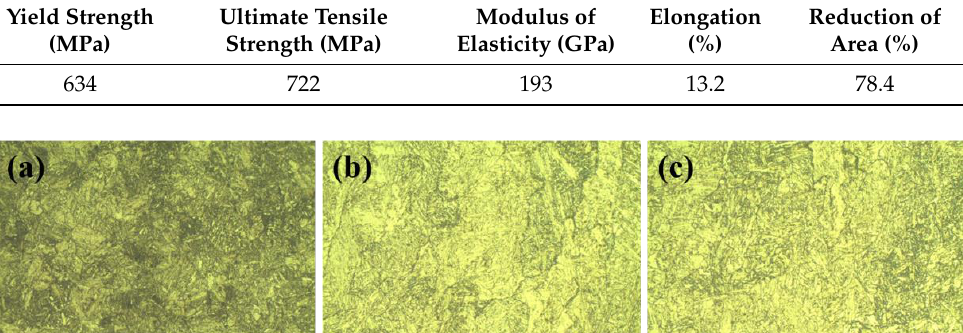
Figure 1. OM observation of microstructures of the welded joint: ( a ) WM, ( b ) BM, ( c ) HAZ.